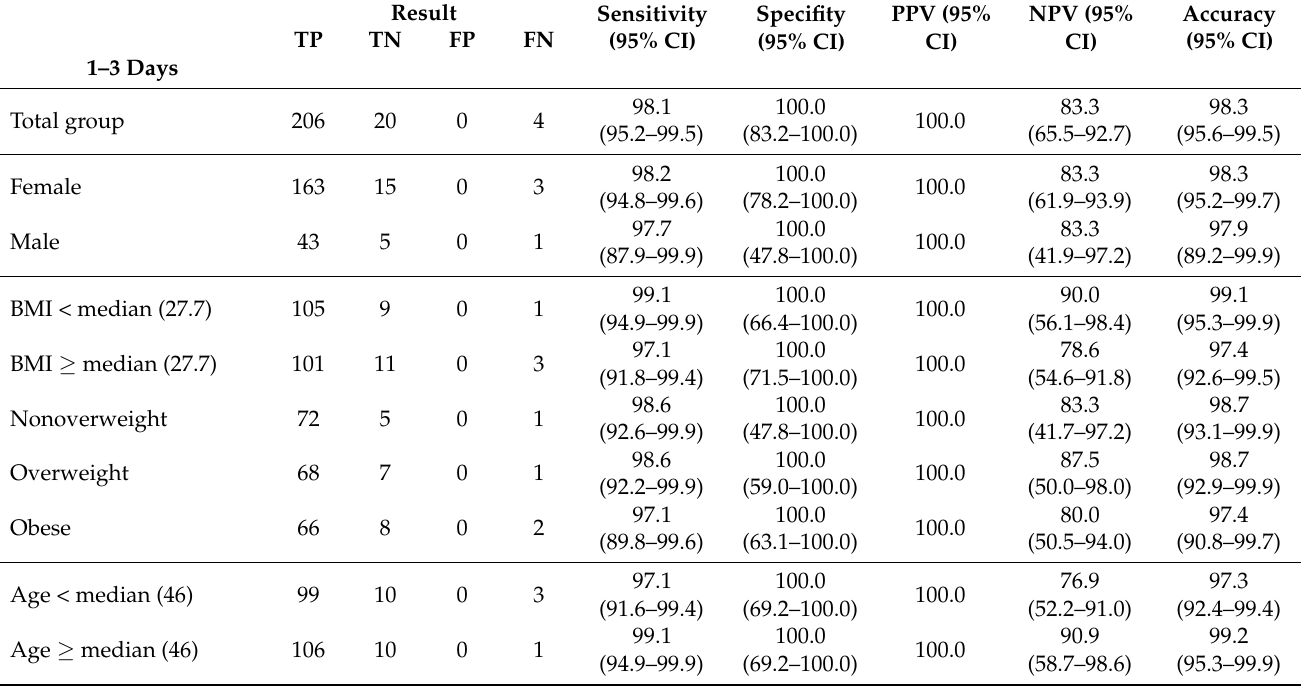
Table 5. Validity analysis of TLUS vs. laryngoscopy.